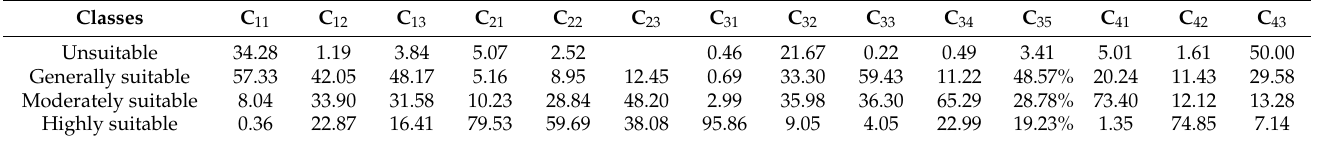
Table 6. Single-factor suitability class proportion statistics for tea cultivation